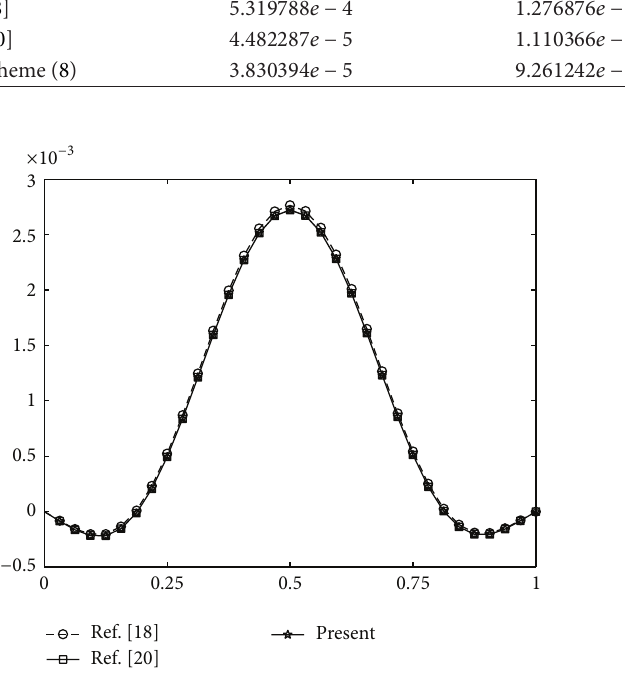
Figure 6: Numerical solutions at different time with ℎ = 1/32 , 𝜏 = 0.1 , 𝛽 = 1 , 𝛼 = 2 , and 𝑝 = 8 .